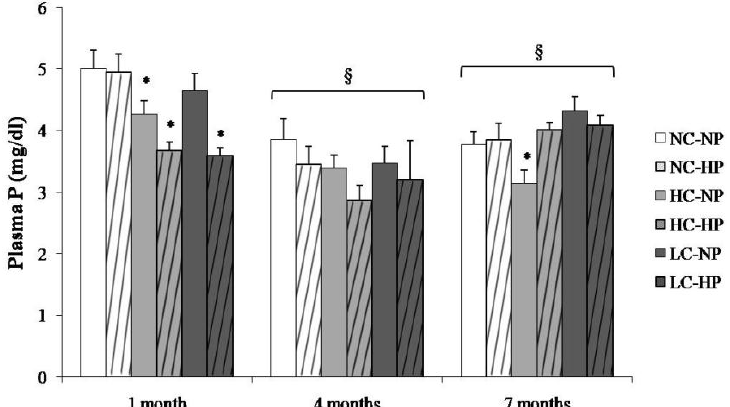
Figure 2. Plasma concentrations of phosphorus (P) at the three sampling times (1, 4 and 7 months) in rats fed diets with normal calorie-normal phosphorus (NC-NP), normal calorie-high phosphorus (NC-HP), high calorie-normal phosphorus (HC-NP), high calorie-high phosphorus (HC-HP), low calorie-normal phosphorus (LC-NP) and low calorie-high phosphorus (LC-HP). n = 8 rats per group. * p < 0.05 vs. NC-NP. § p < 0.05 vs. 1 month. Table 1. Blood biochemistry at the end of the experiments (7 months) in rats fed diets with normal calorie-normal phosphorus (NC-NP), normal calorie-high phosphorus (NC-HP), high calorie-normal phosphorus (HC-NP), high calorie-high phosphorus (HC-HP), low calorie-normal phosphorus (LC-NP) and low calorie-high phosphorus (LC-HP).